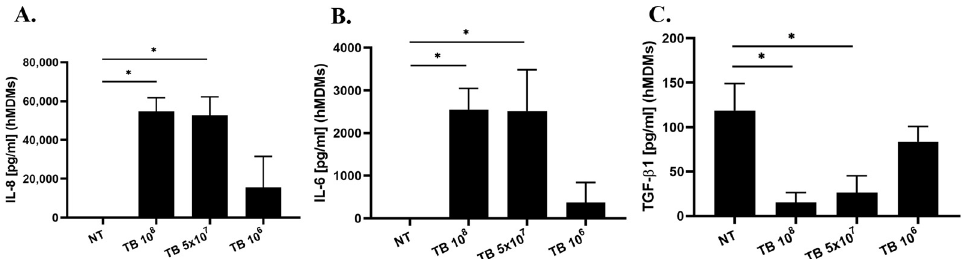
Figure 8. Effect of TB on the release of ( A ) IL-8, ( B ) IL-6 and ( C ) TGF- β 1 by hMDMs. hMDMs were incubated with the indicated concentrations of TB for 4 h, and the effect on the protein release of IL-8, IL-6 and TGF- β 1 was assessed by ELISA. Data are expressed as mean ± SD (N = 5). For statistical analysis, repeated measures ANOVA with Bonferroni post hoc test was applied. * p < 0.05 vs. NT.